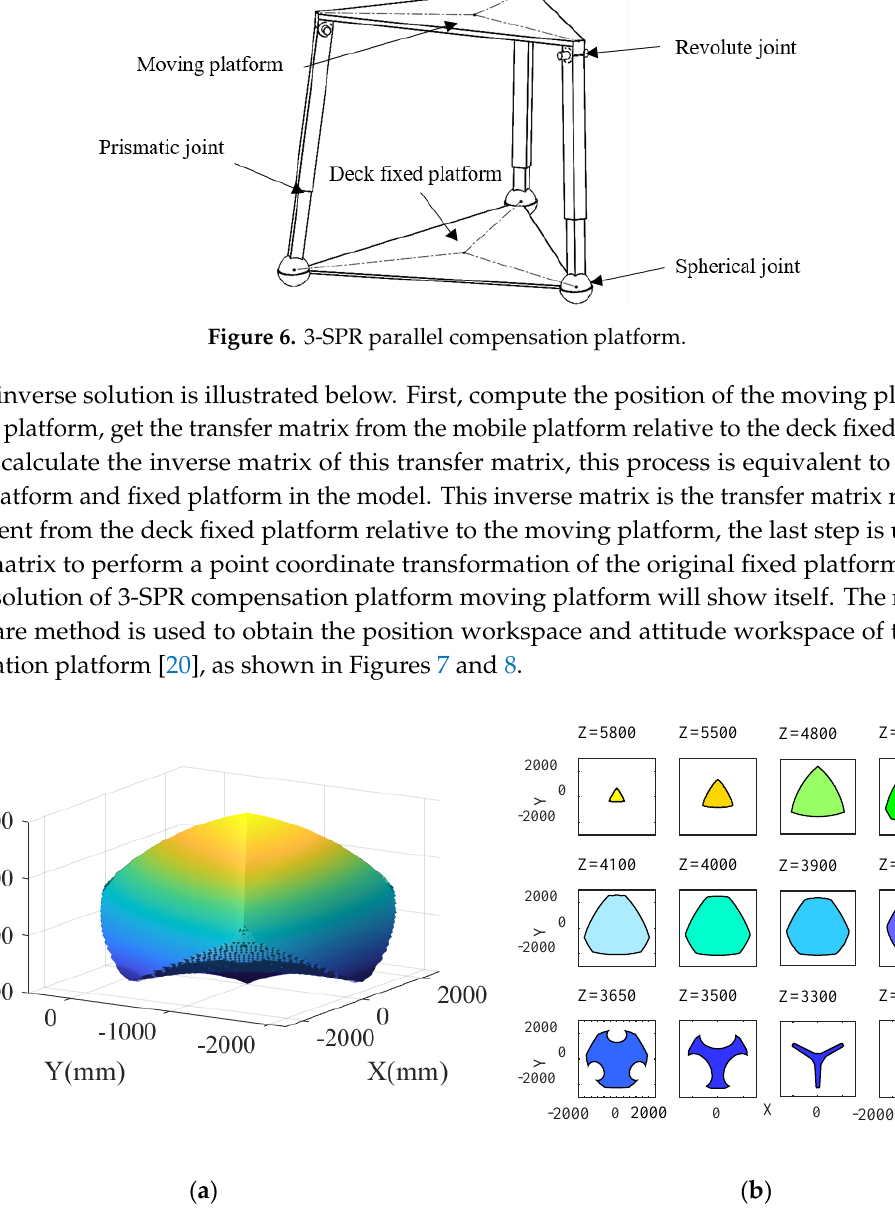
Figure 7. Position workspace of the 3-SPR compensation platform. ( a ) The 3D shape of the position workspace; ( b ) slice figure of different altitudes.